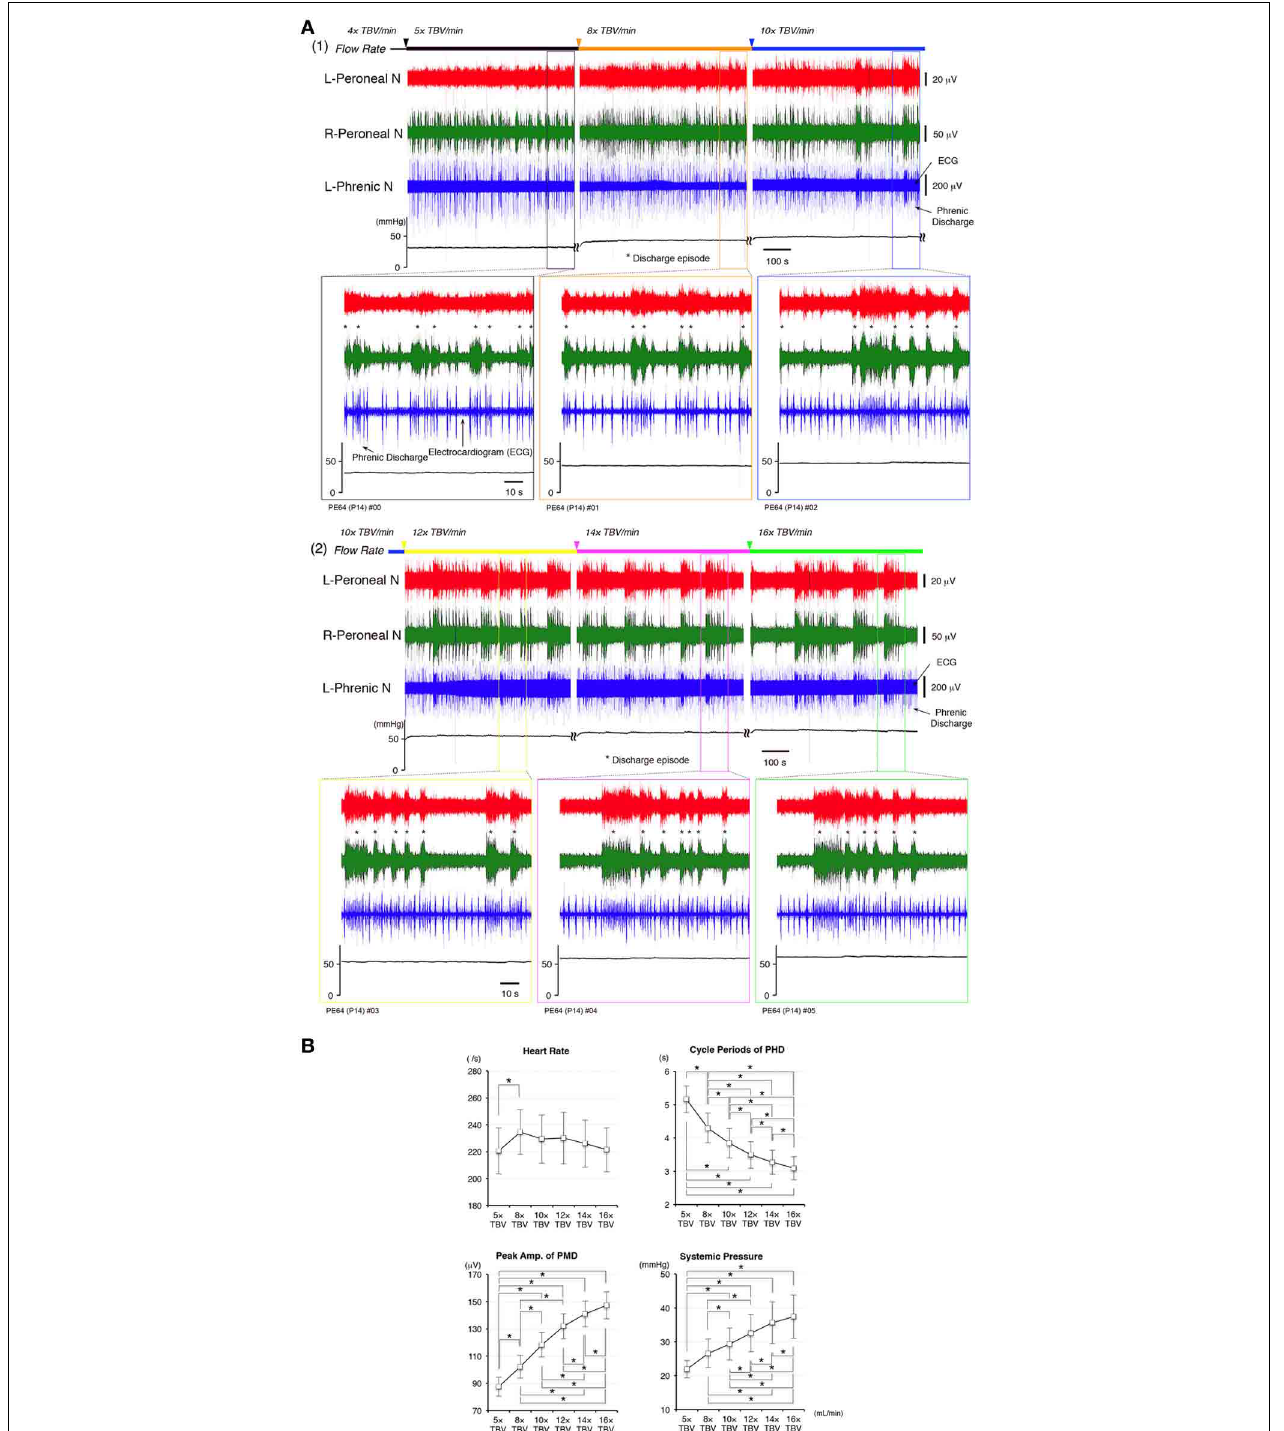
FIGURE 2 | (A) Recordings showing perfusion flow dependence of systemic pressure and phrenic and peripheral nerve discharge in a decerebrate and arterially perfused in situ mouse preparation. (1) Data collected on perfusion flow dependence at 4 × to 10 × and (2) at 12 × to 16 × TBV/min. Phrenic discharge containing the ECG, and left and right peroneal nerve discharge were recorded at the various flow rates at room temperature. The upper panels show the systemic pressure, while the lower panels present an